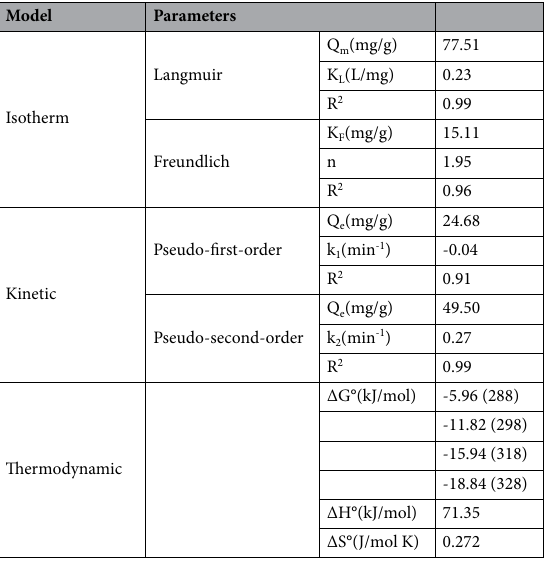
Table 2. Isotherm, kinetic, and thermodynamic parameters for adsorption of lead(II) onto PmPDA@ZnO nanocomposite.